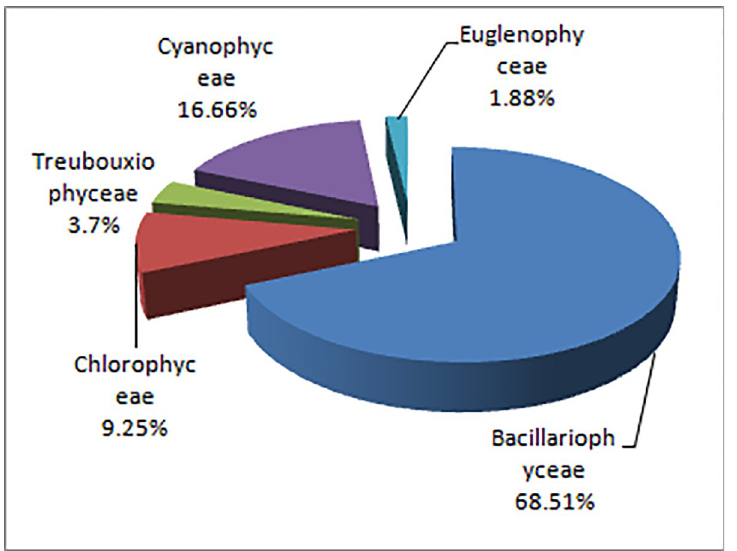
Fig 3. Compositions of algal group in the sampling